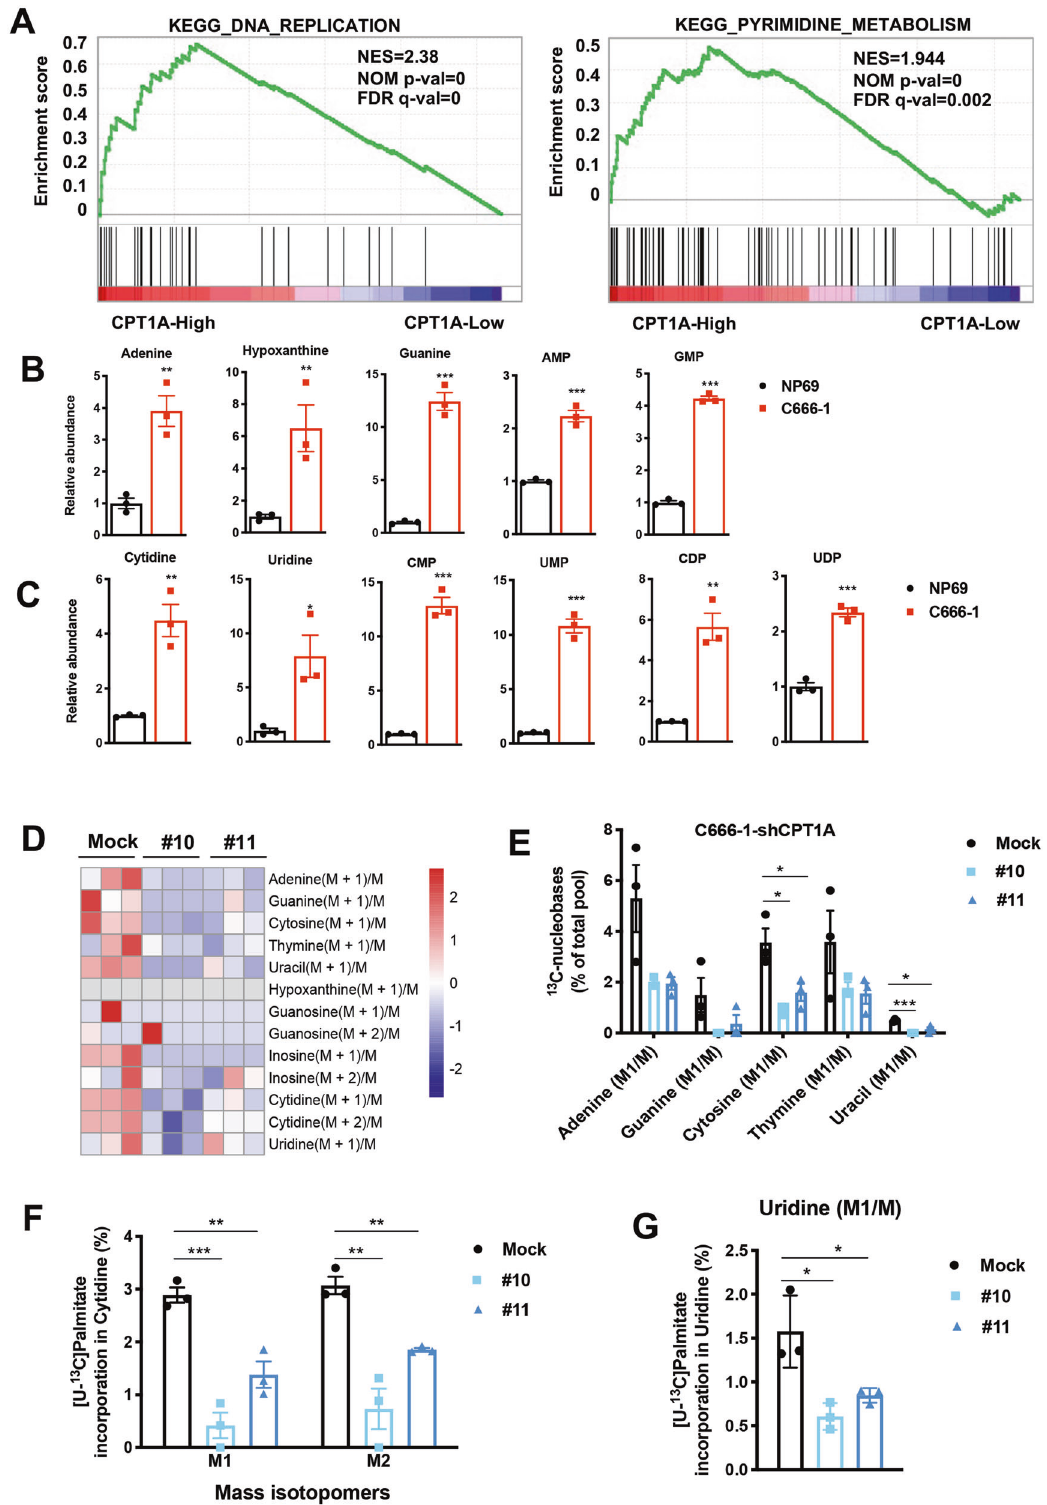
Increased genomic disruption has been associated with poor prognosis in many cancer types [45]. Metabolic gene ampli fi cation accompanies canonical oncogene drivers in cancer [46]. Ampli fi cation of the 11q13 chromosome region has been reported in advanced OPSCC [47], HNSCC [48, 49], and Cell Death and Disease (2022)